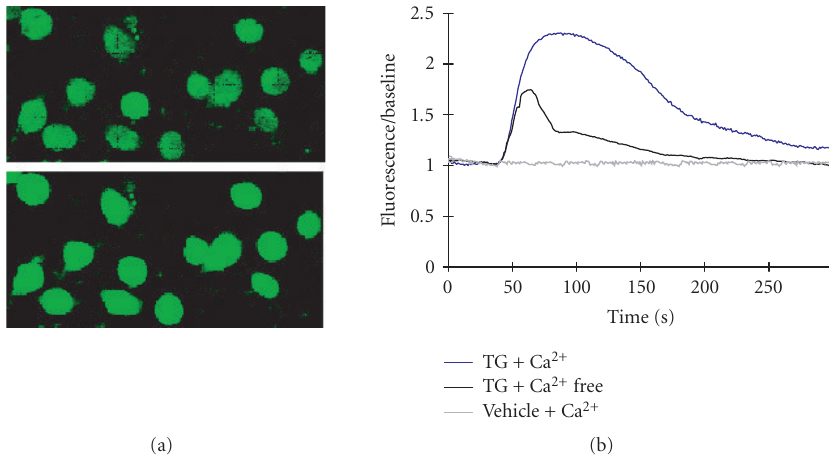
Figure 1: Thapsigargin induced an elevation of [Ca 2+ ] i in RAW264.7 cells. (a) The upper panel is an image of resting RAW264.7 cells loaded with Fluo-3/AM, and the lower panel shows typical Ca 2+ responses obtained after stimulation with thapsigargin (2 μ M) in the presence of external Ca 2+ . (b) Intracellular Ca 2+ signals to thapsigargin in the absence and presence of external Ca 2+ . Figure 1(b) is representative of four experiments performed on di ff erent experimental days. TG: